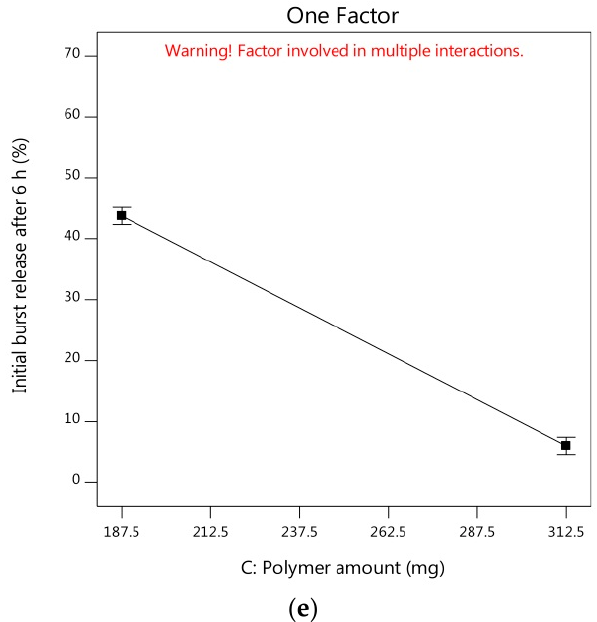
Figure 2. One factor plot of influence of independent factors on Y 1 response ( a ) effect of A using DMSO and medium level of C ( b ) effect of A using NMP and medium level of C ( c ) effect of B using medium levels of A and C ( d ) effect of C using DMSO and medium level of A ( e ) effect of C using NMP and medium level of A.